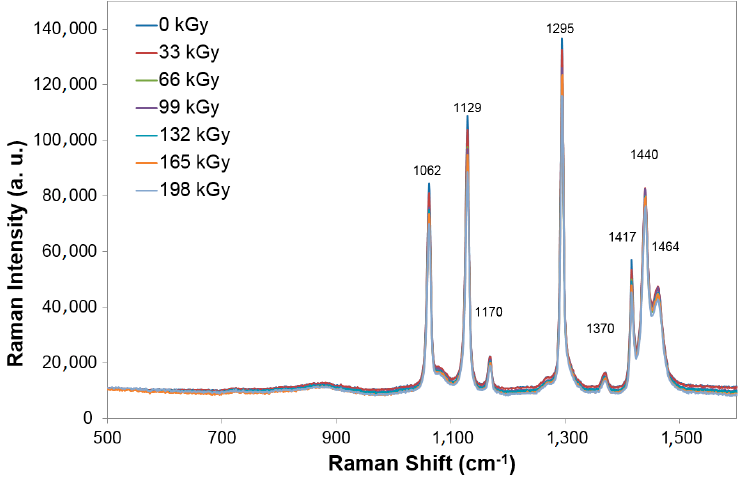
Figure 6. Raman spectroscopy—Commodity polymers (HDPE).